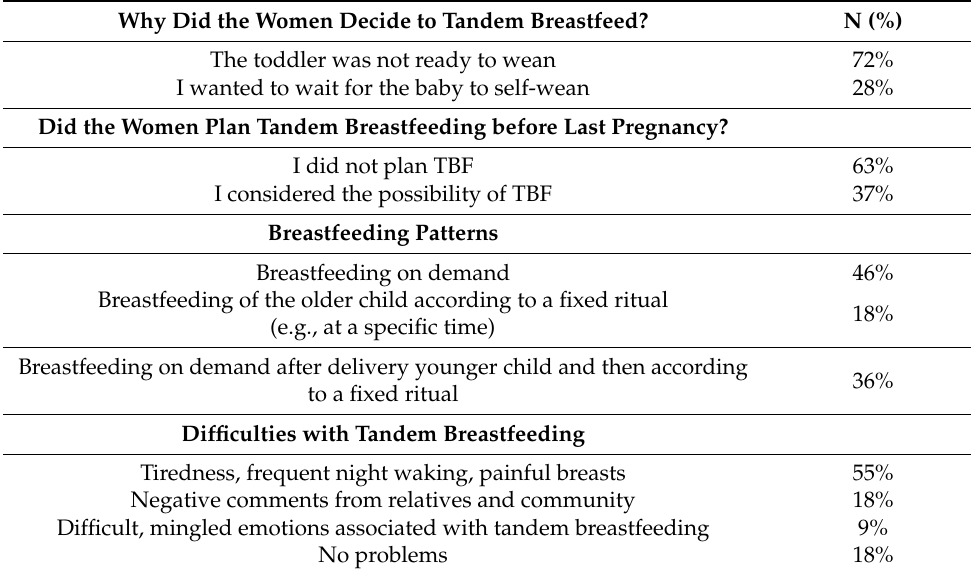
Table 4. Characteristic of tandem